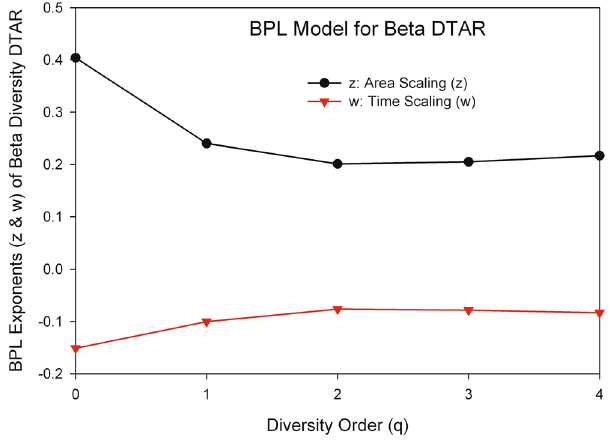
Figure 8. The parameters z & w of the BPL (bivariate power law) for the